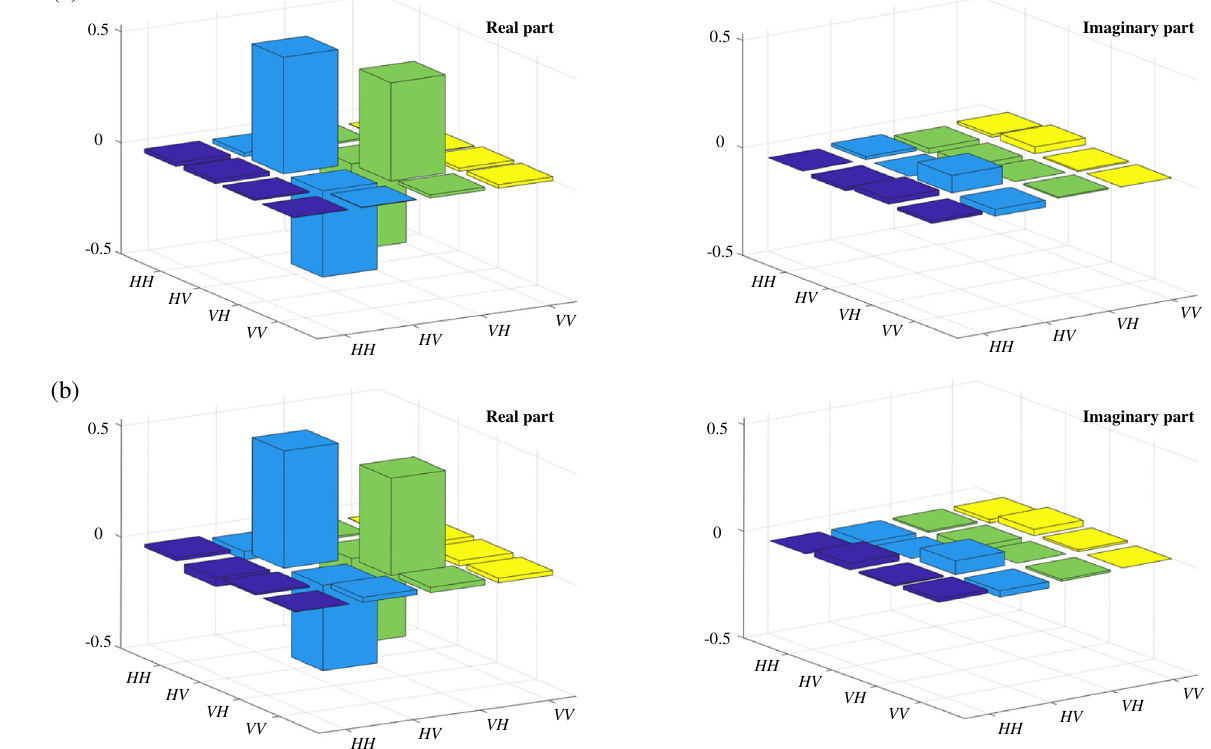
FIG. 2. Quantum entanglement between the idler photon and the signal photon before and after 10-km transmission in the fiber. (a) The reconstructed density matrix of the idler photon and the signal photon before the 10-km transmission. This is the original state of the generated polarization-entangled photon pair with a cross-correlation of 38 along with a pump excitation rate 0.13% of the signal photon and a coincidence counting rate above 3 Hz. The fidelity is ð 87 . 8 (cid:2) 2 . 6 Þ % . (b) The reconstructed density matrix of the idler photon and the signal photon after the 10-km transmission. The cross-correlation between the idler photon and the signal photon after transmission is 24, along with a pump excitation rate 0.10% of the signal photon and a coincidence counting rate above 2 Hz. The fidelity is ð 86 . 9 (cid:2) 2 . 3 Þ % , and the transmission fidelity is ð 95 . 4 (cid:2) 1 . 7 Þ %